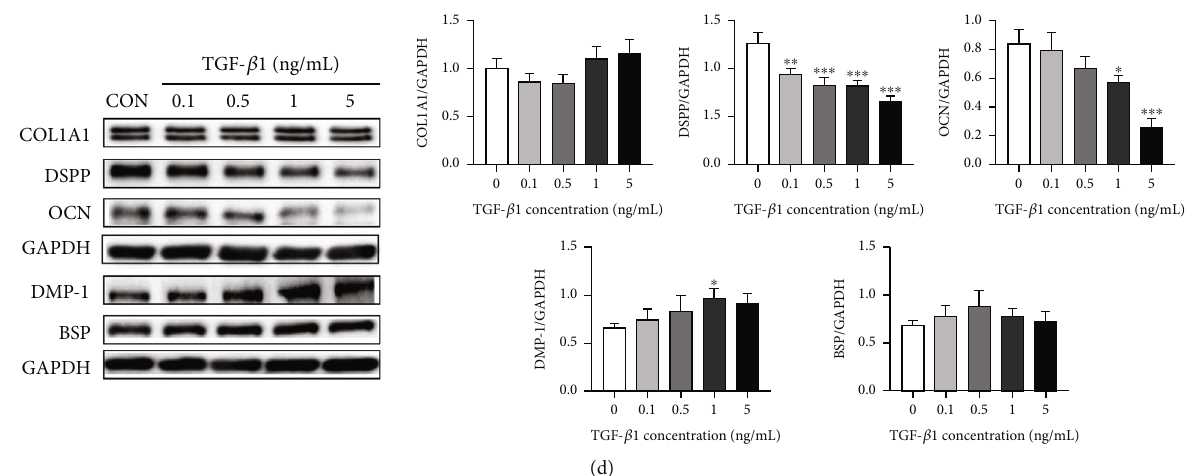
Figure 4: E ff ect of TGF- β 1 on odonto-/osteo-genic-related marker gene and protein expression in DPSCs in vitro (a) The expression levels of COL1A1, DSPP, OCN, BSP, and DMP-1 were detected by qRT-PCR at day 7. (b) Relative gene expression levels of the genes at day 14. (c) Western blot analysis and quanti fi cation of proteins expression at day 7 after TGF- β 1 exposure. (d) Analysis of protein expression after 14 days. Errorbars = means ± standard deviation (SD), n = 3 , statistically signi fi cant di ff erence at the levels ∗ p < 0 : 05 , ∗∗ p < 0 : 01 , and ∗∗∗ p < 0 : 001 (ANOVA) compared with the control group. BSP: bone sialoprotein; COL1A1: collagen type 1 alpha 1; DMP-1: dentin matrix protein 1; DPSCs: dental pulp stem cells; DSPP: dentin sialophosphoprotein; OCN: osteocalcin; TGF- β 1: transforming growth factor- β